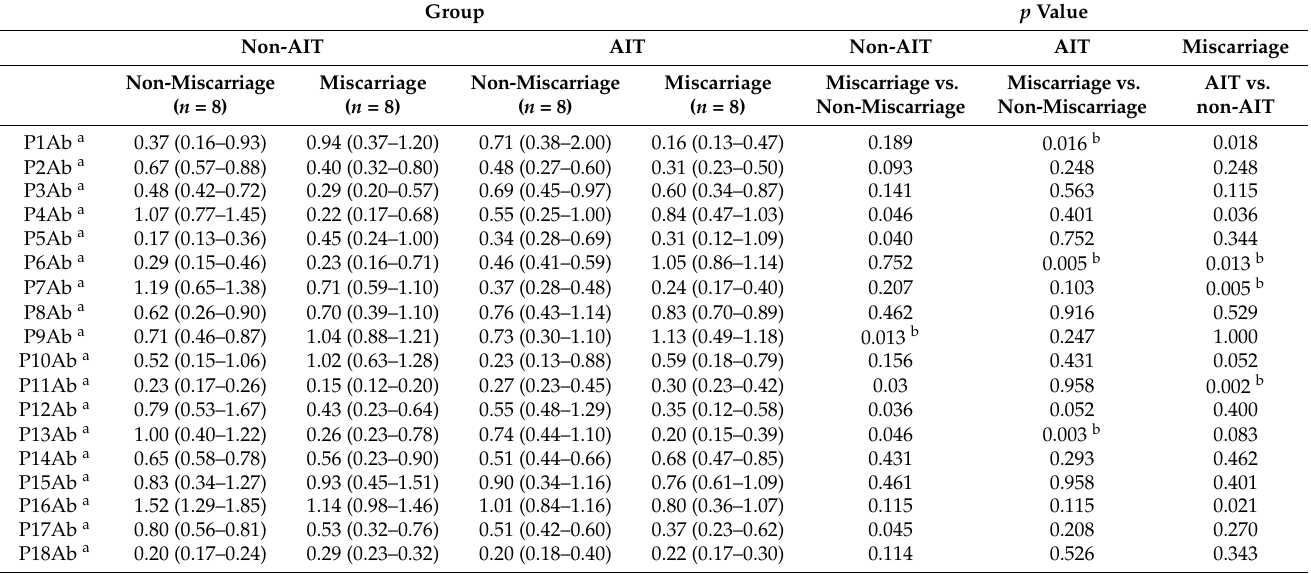
Figure 2. Relationship between serum levels of total IgG against ENO1 and the development of miscarriage in AIT participants. The ROC curve of the serum ENO1Ab expression for miscarriage prediction ( A ), and the titer-dependent association between serum ENO1Ab levels after quartile stratifications and the prevalence of miscarriage ( B ). Table 4. The serum levels of autoantibodies against P1–P18 antigen epitopes of Table 3. Spearman correlation analysis of ENO1Ab expression with serum levels of FT4, TSH, TPOAb, and TgAb in AIT women.